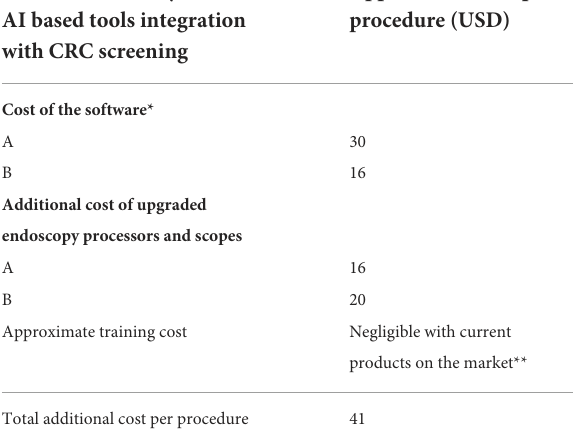
TABLE 2 Approximate costs of integrating AI based tools into the colonoscopy screening programs. Detailed cost analysis